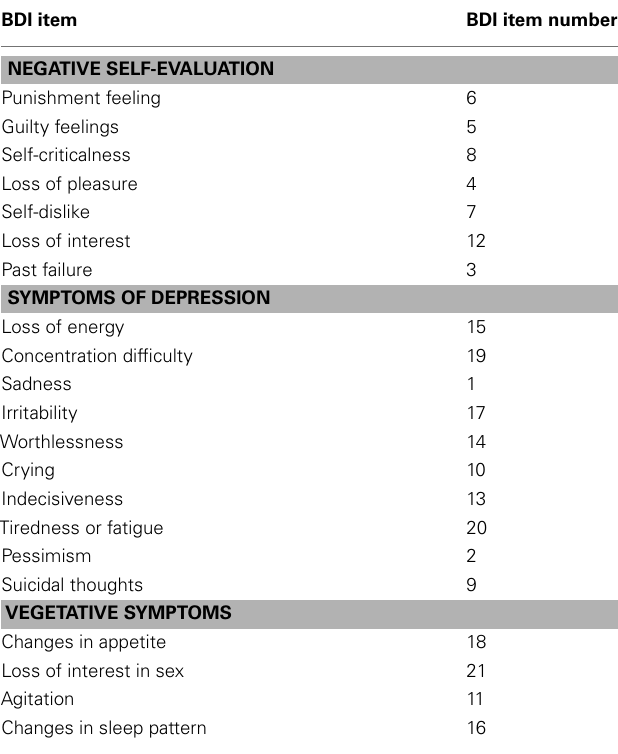
Table 7 | Depression subscales in aTBI population based on the Beck depression inventory-II